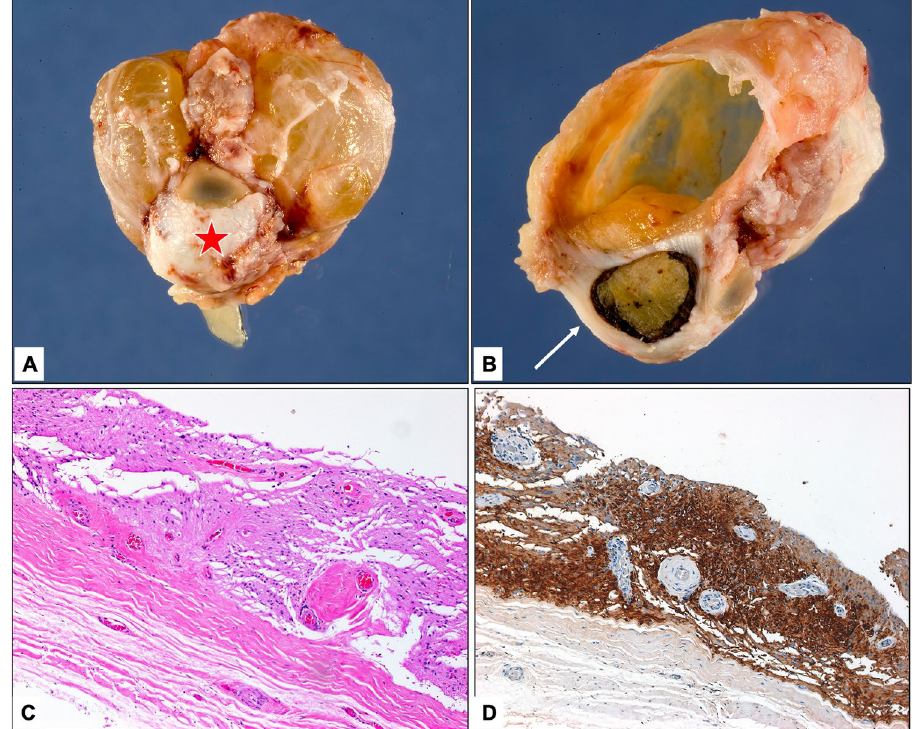
Figure 3. ( A,B ) An example of severe microphthalmos (globe is marked with a red star in ( A ) and a white arrow after sectioning in ( B )) associated with a large cyst. ( C ) The histopathological neuroglial lining of the cyst wall (original magnification × 100, hematoxylin and eosin). ( D ) Staining of the wall with glial fibrillary acidic protein (GFAP) (original magnification × 100, GFAP).